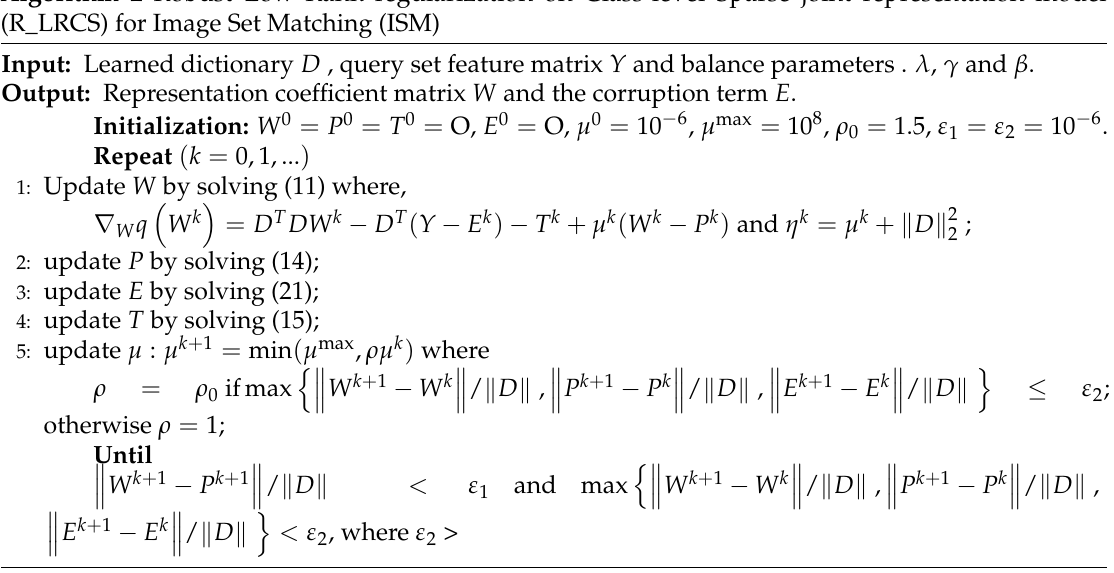
Algorithm 2 Robust Low Rank regularization on Class-level Sparse joint representation